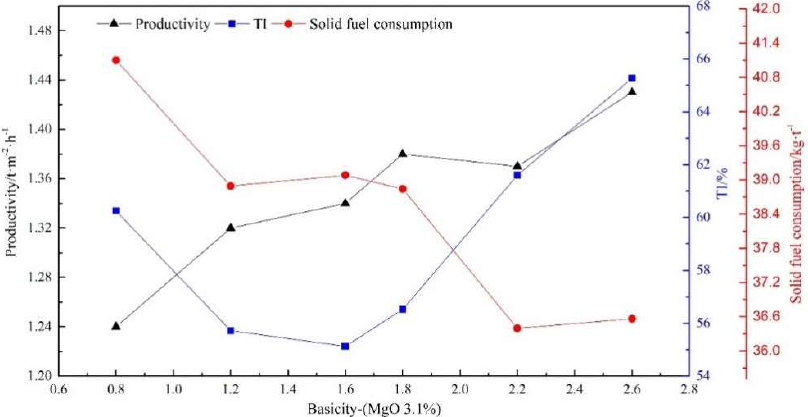
Figure 5. Effect of basicity on sintering performance with 3.1% MgO